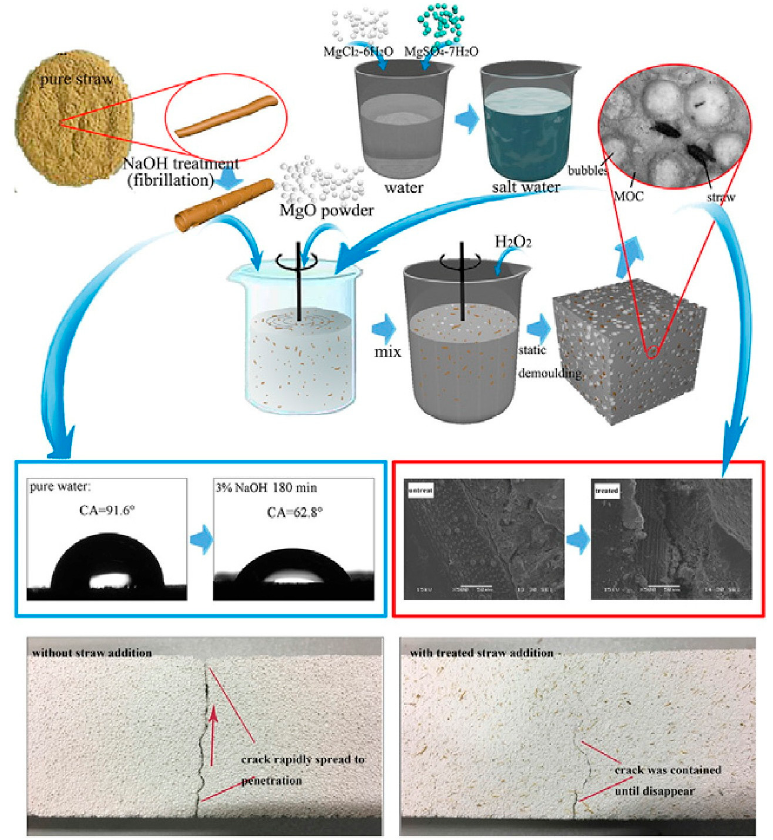
Figure 10. Manufacturing process of the straw/magnesia composite [47].